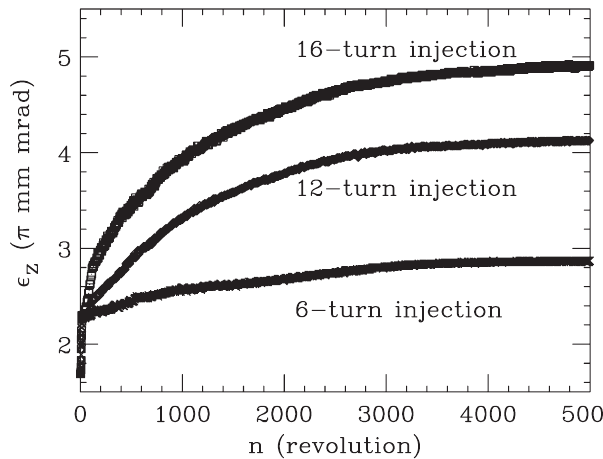
FIG. 37. The evolution of the vertical emittance for beams with 6, 12, and 16-turn injections. The emittance evolution can be compared with those of Fig.